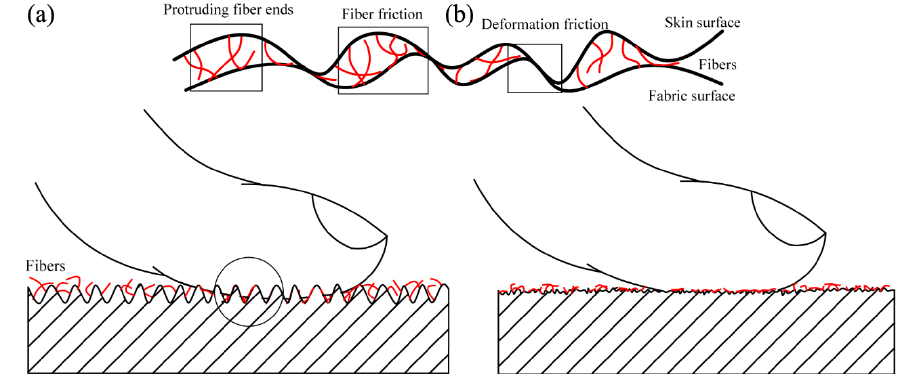
Fig. 6 Schematic diagram of finger touching: (a) rough and (b) smooth fabric surface.